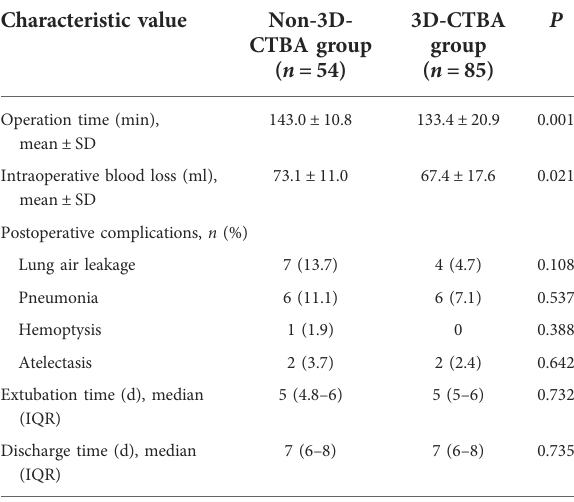
TABLE 2 Comparison of perioperative results between the two groups of patients who underwent segmentation of the right upper lobe. Characteristic value